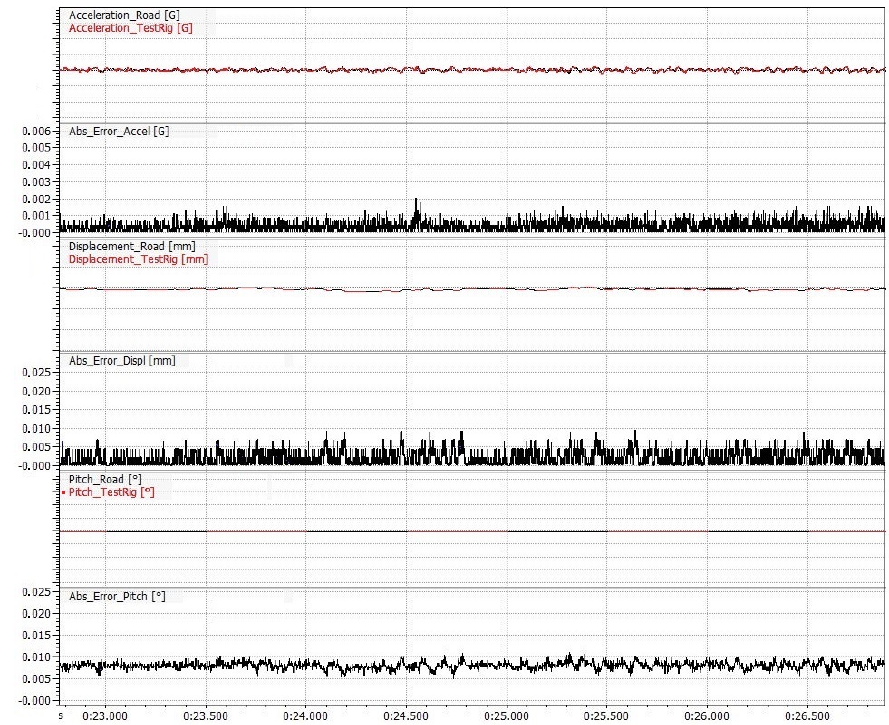
Figure 15. Test performed on smooth paved road at 100 km/h.